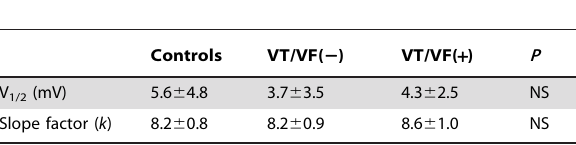
Table 3. Changes in voltage dependence of the KCNH2